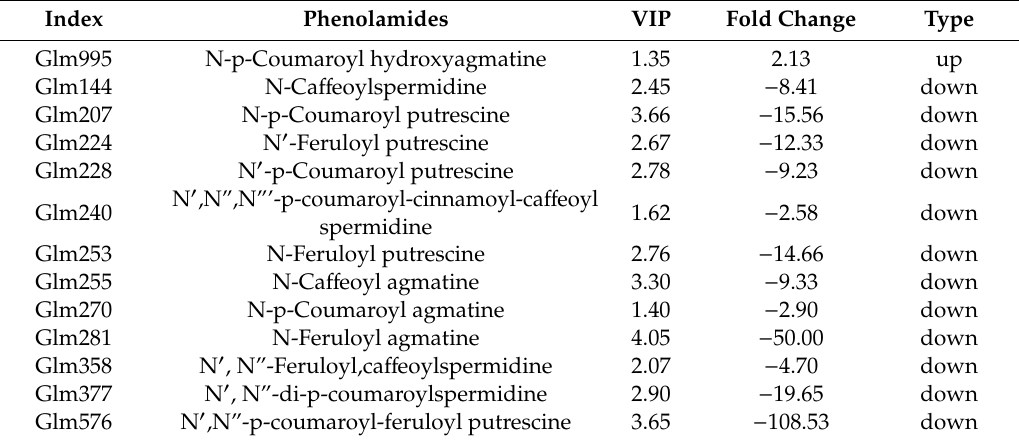
Table 2. Di ff erence of phenolamides in flower buds of NJCMS5A vs.